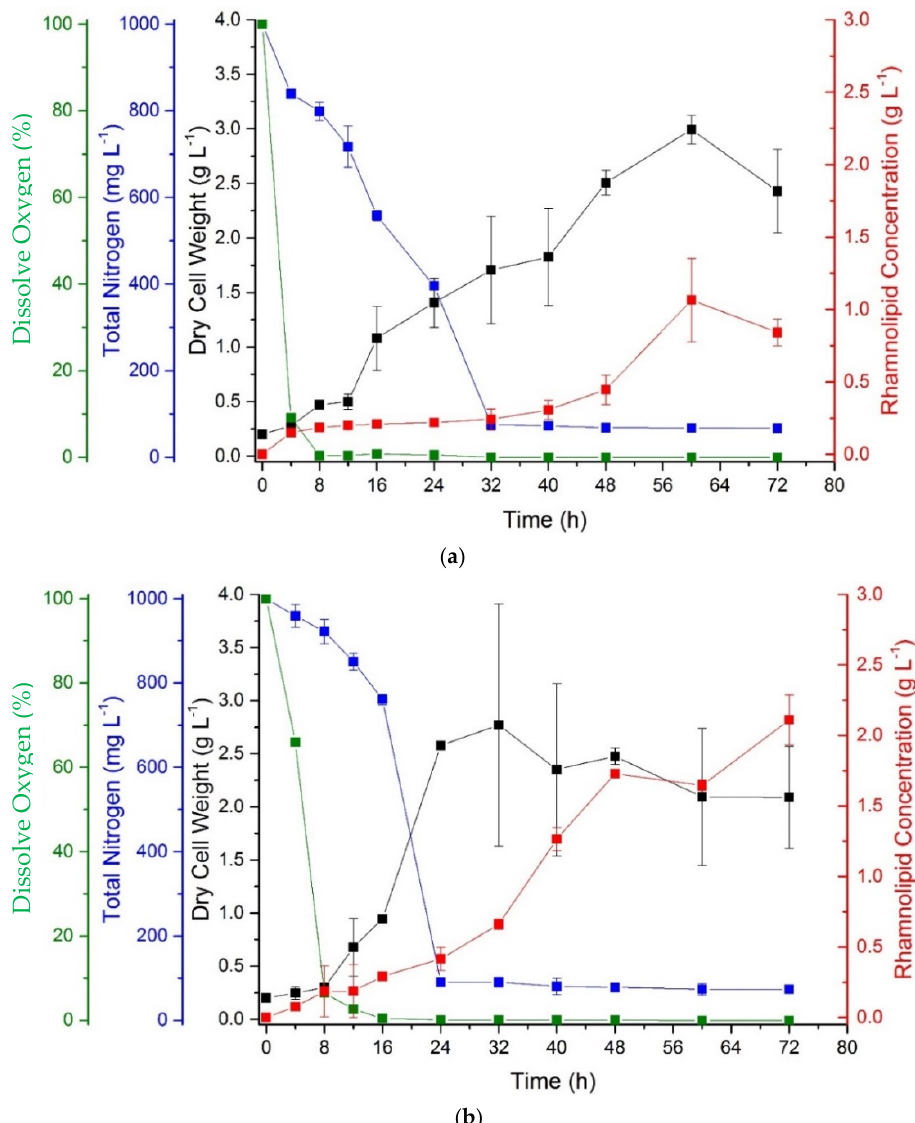
Figure 1. The profiles of P. aeruginosa PAO1 cell growth time path and the production of rhamnolipid in the bioreactor at 150 rpm, 37 ◦ C by using ( a ) PFAD and ( b ) FAME as sources of